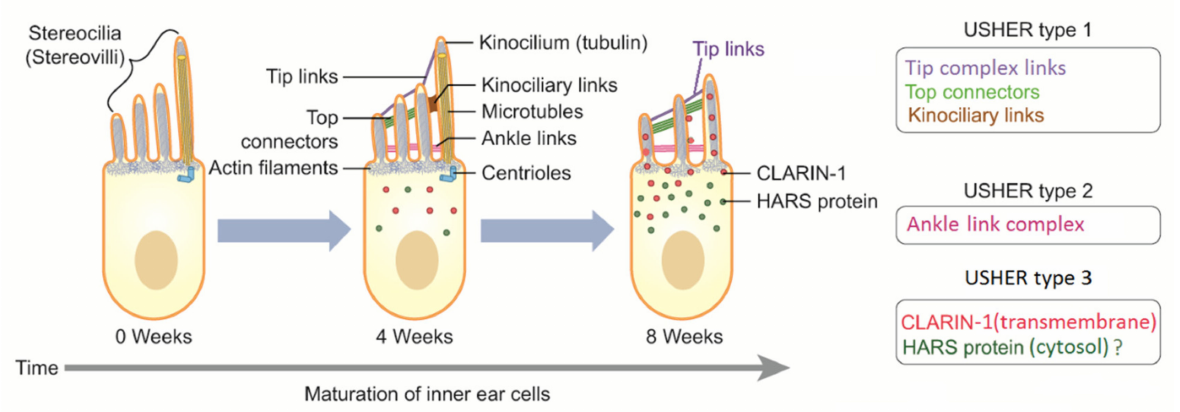
Figure 3. Simplified and schematic representation of the maturation process that involves sensorineural cells in the inner ear. Only one kinocilium and many different stereocilia (stereovilli) for each cell are presented. Kinocilia are intracellular, transmembrane, and extracellular proteins that drive maturation and orientation of stereocilia in the sensorineural epithelium. Inner and outer hair cells, and vestibular type II hair cells lose their kinocilium during maturation; the kinocilium disappears in the final form. Transient links degenerate, and tip links, top connectors, and ankle links assume their final functional form. This reorganization of tip links, transient lateral links, top connectors, kinociliary links, and ankle links refers to the normal functions of actin filaments and several Usher proteins. Centrioles are also very important in leading a vital process during cell life. Hearing loss and equilibrium disorders may be derived from mutations in different genes that express proteins involved in different levels and in different times of maturation of the sensorineural cells. Clarin-1 protein (in red) is a four- transmembrane protein that is synthetized and collected in the cytosol and then transported to cellular membrane during maturation processes. The role of HARS1 gene in USH type 3 must be